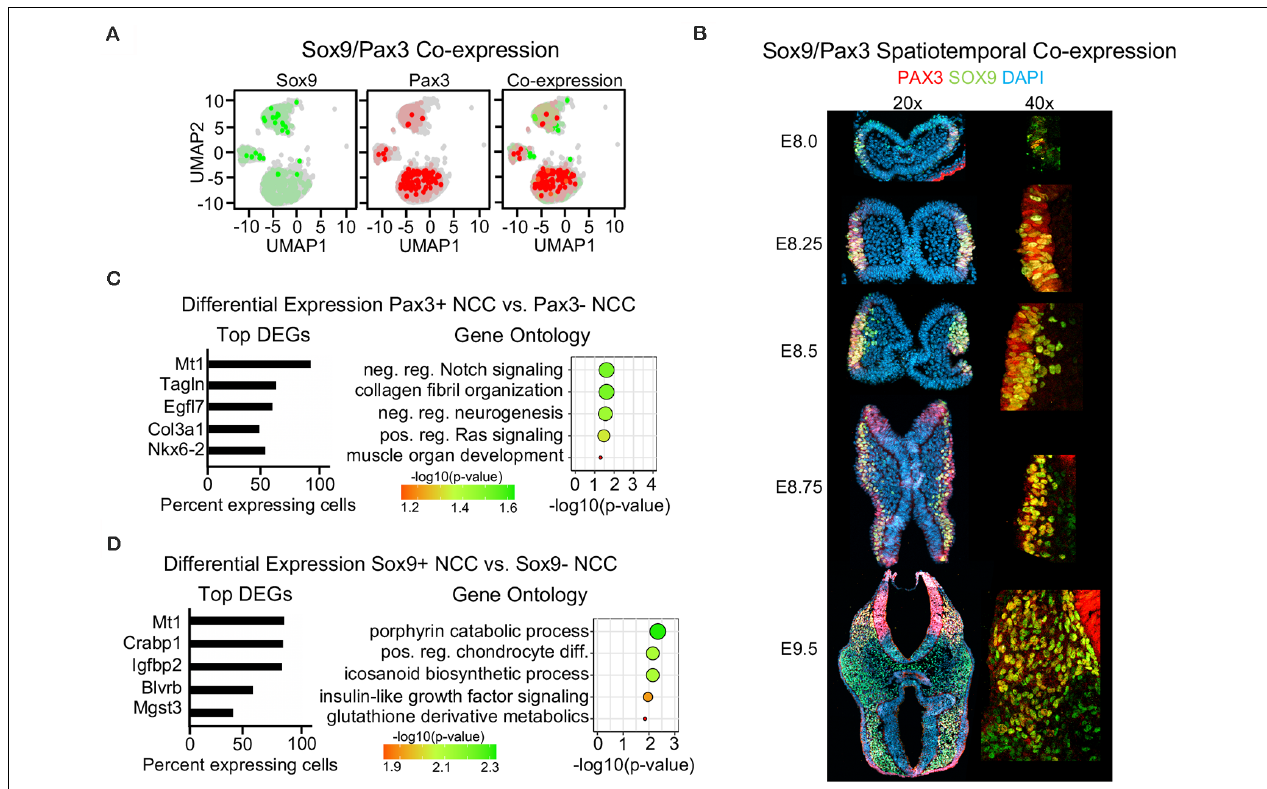
FIGURE 5 | Single-cell sequencing reveals little co-expression of Sox9 and Pax3 in E9.5 neural crest cells. (A) Blended UMAP plot showing little co-expression of Sox9 and Pax3 . (B) Immunofluorescence of transverse mouse embryo sections for PAX3 and SOX9 from E8.0 to E9.5. (C) Bar plot of differentially expressed genes and GO analysis of Pax3 -positive cells and (D) Sox9 -positive cells at